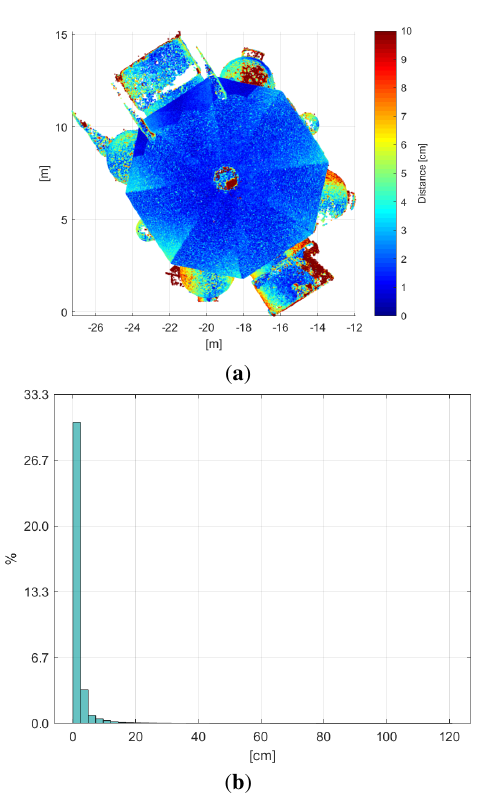
Figure 9. Photogrammetric 3D model of Savonarola gate (with optimal scale factor) accuracy assessment: comparison with the TLS 3D model. Point clouds registered in local coordinates with the ICP algorithm. ( a ) Map of point-to-point distances. ( b ) His- togram of distances shown in ( a ).